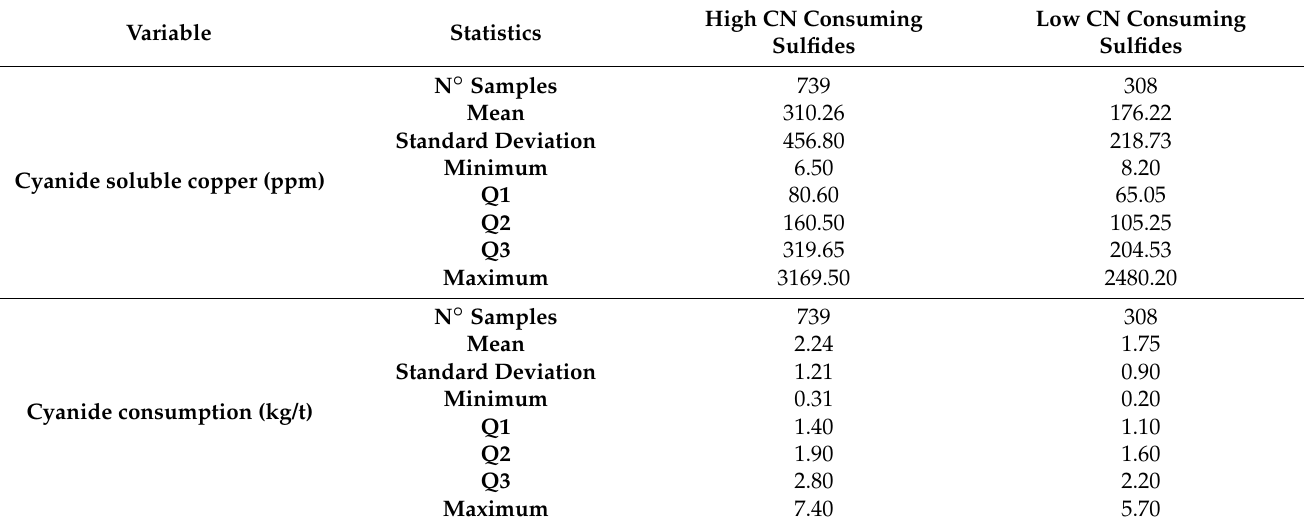
Table 2. Cyanide consumption per geometallurgical